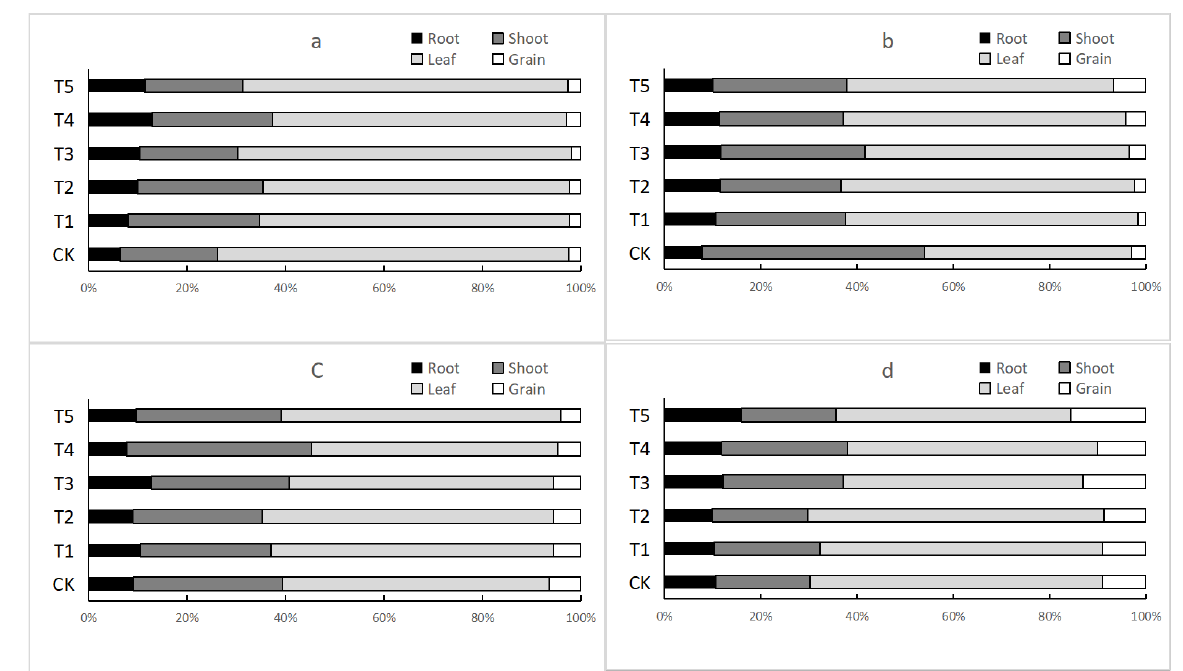
Figure 1. Cadmium accumulation in the roots, stems, leaves, and grains of Huayu 23 and Huayu 20. ( a ) Huayu 23 with high cadmium pollution; ( b ) Huayu 20 with high cadmium pollution; ( c ) Huayu 23 with low cadmium pollution; ( d ) Huayu 20 with low cadmium pollution.